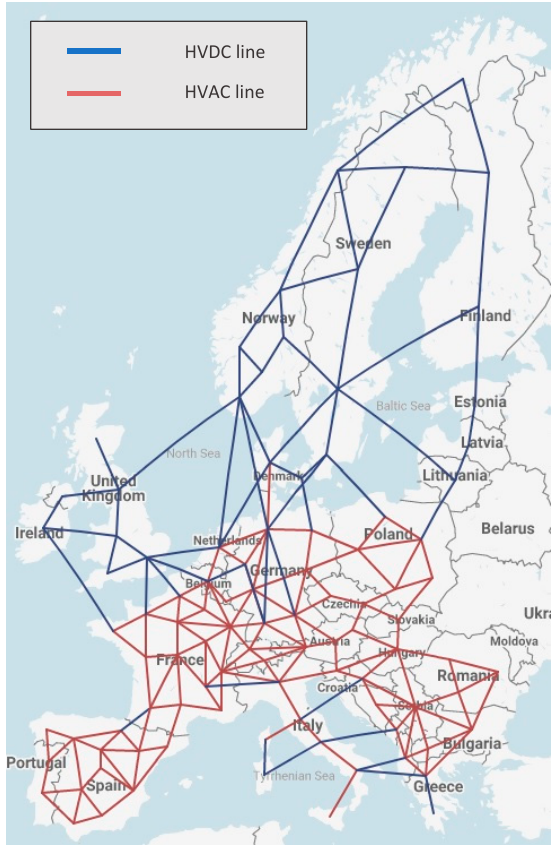
Figure 3. Reduced European Electricity Grid in 2030 (Data from [53]).